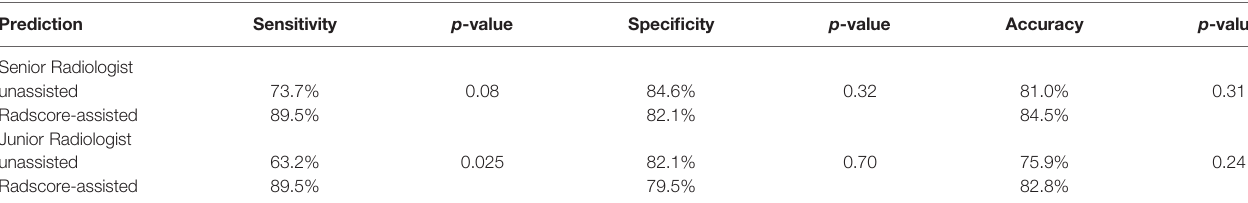
TABLE 4 | Comparison of unassisted and assisted performance in each radiologist on the validation